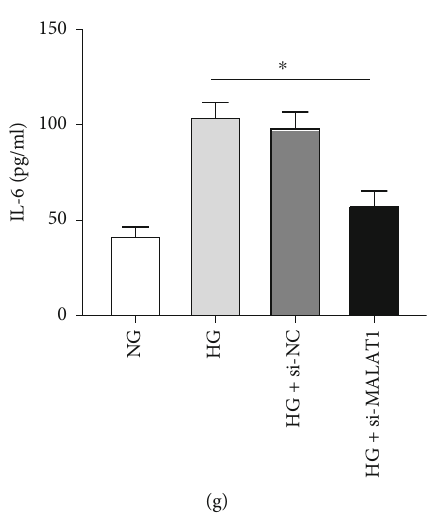
Figure 2: Knockdown of MALAT1 attenuates HG-induced cell viability inhibition, apoptosis, and expression of in fl ammatory cytokines in HK-2 cells. (a) qRT-PCR analysis of MALAT1 in HK-2 cells after transfection with si-MALAT1 or si-NC. ∗ p < 0 : 05 versus the HG or si-NC group. (b) Cell viability by CCK-8 assay. ∗ p < 0 : 05 versus the HG or si-NC group. (c, d) Cell apoptosis by TUNEL assay. ∗ p < 0 : 05 versus the HG or si-NC group. (e – g) ELISA analysis of TNF- α , IL-1 β , and IL-6. ∗ p < 0 : 05 versus the HG or si-NC